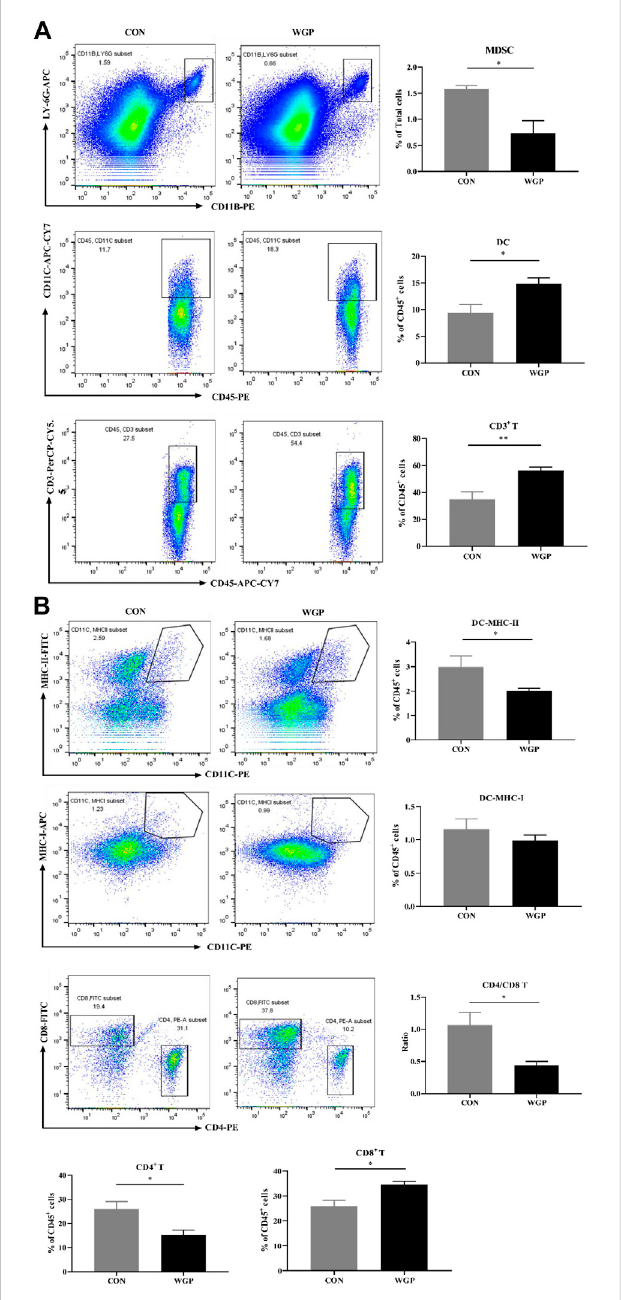
FIGURE 5 WGP-treatedmicewithDSS-inducedchroniccolitiswereanalyzed by fl ow cytometry (A) The frequency of MDSCs (CD11b + LY-6G + ), DCs (CD45 + CD11c + ),andTcells(CD45 + CD3 + )inthecLPafteradministration of DSS. (B) The percentages of DC and T-cell subtypes. Dot plots are gated on CD45 + cells. Data indicate the mean ± SEM of each group ( n = 4 – 5) obtained from three independent experiments. Statistically signi fi cantdifferencesareshown.* p < 005,** p < 001,*** p < 0,001,n.s. means no signi fi cant